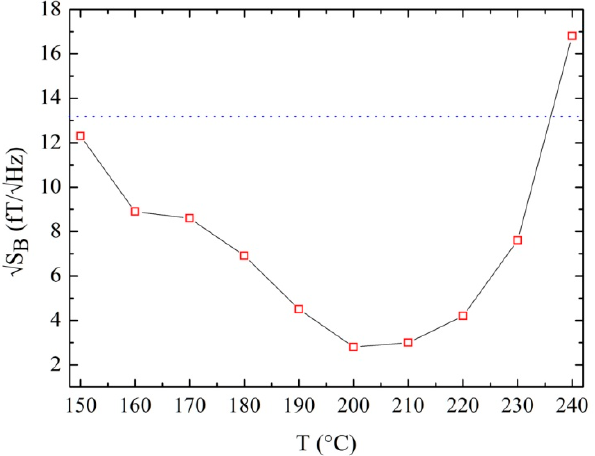
Figure 5. White spectral density of magnetic field noise as a function of the annealing temperature measured a T = 4.2 k in flux-locked-loop mode. The solid black line is just an eye-guide line.